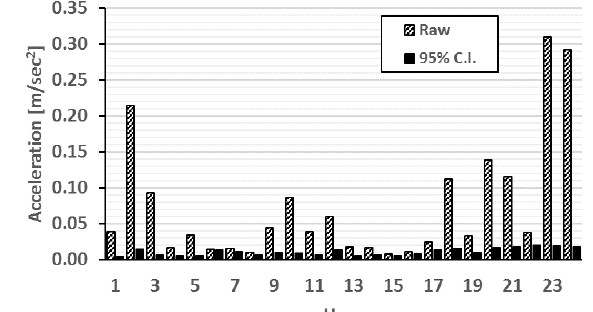
Figure 12 Hourly mean peak acceleration in 2011